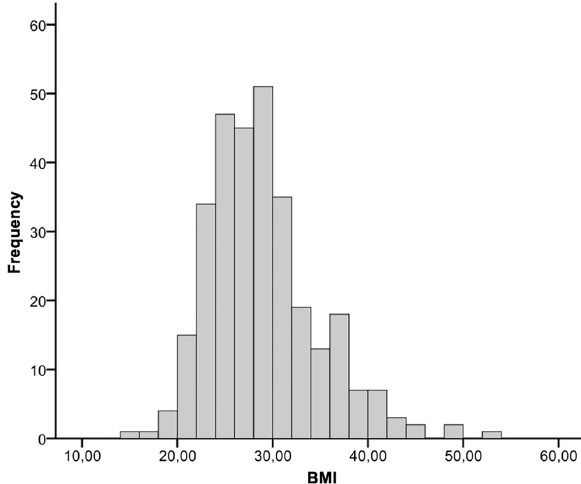
Figure 1. Histogram of the BMI of the patients evaluated in this study. Mean ± standard deviation of the mean: 28.99 ± 0.33.